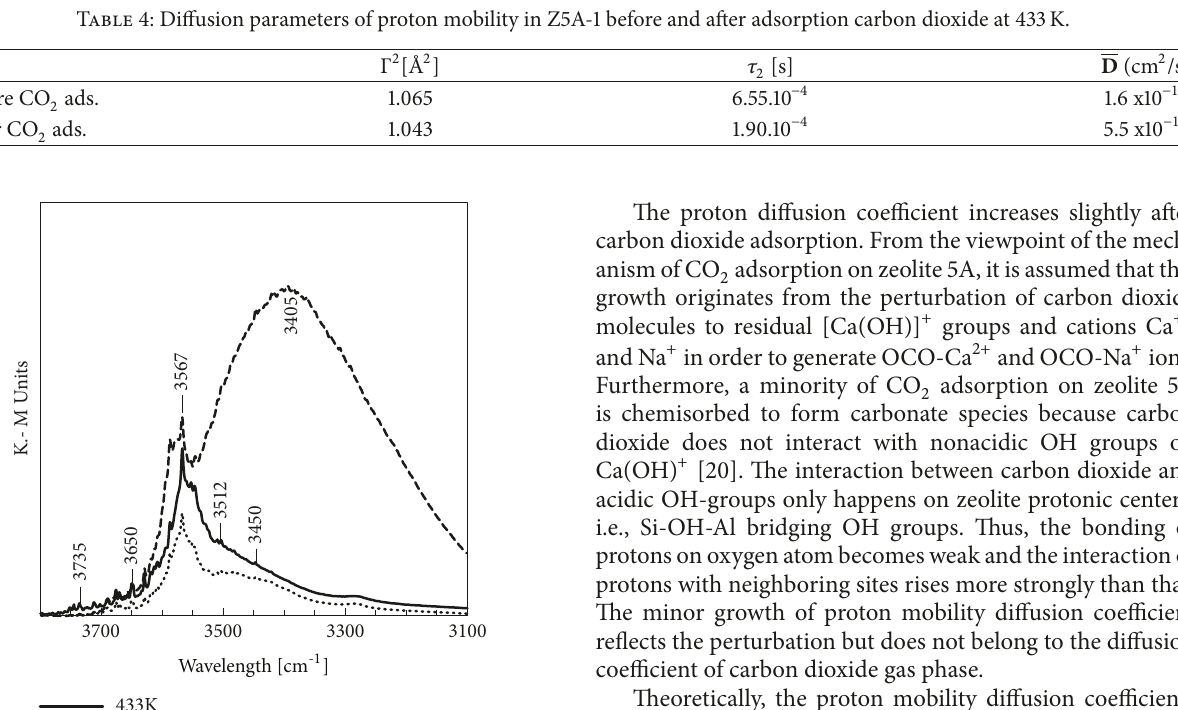
Table 3: Parameters for calculation of CO 2 interaction on zeolite by Bandara-Mellander’s model. f m [Hz] tan( 𝜙 ) 𝛿 Before CO 2 ads. After CO 2 ads.